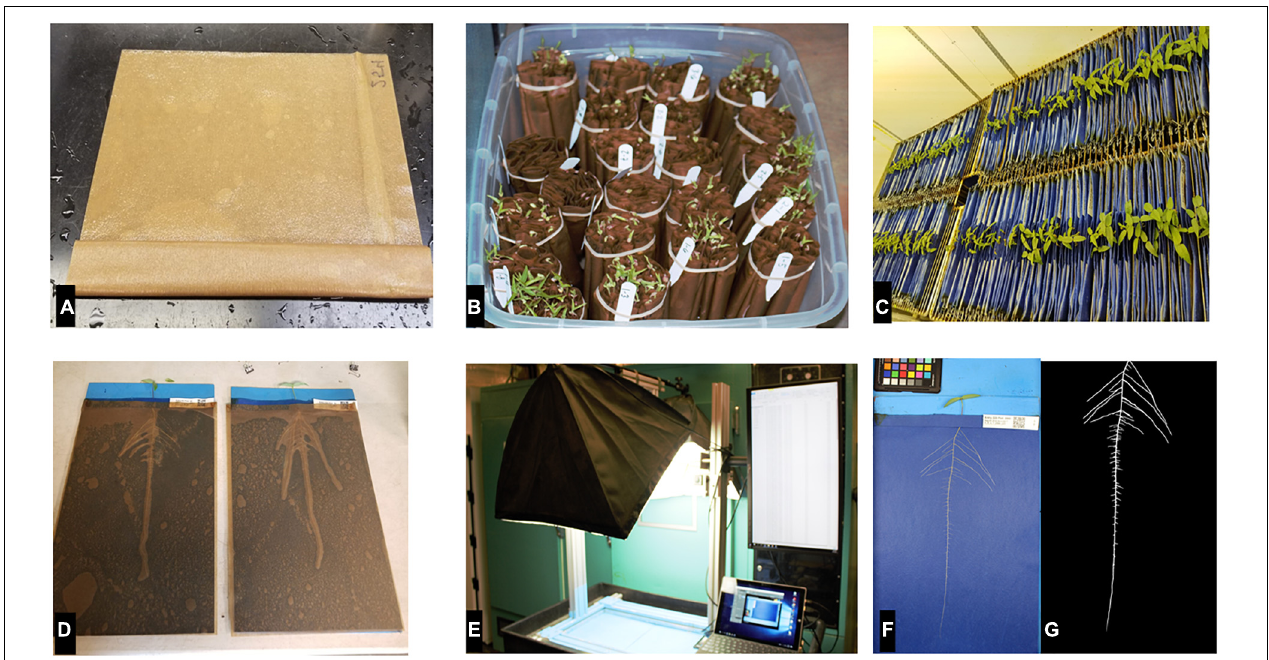
FIGURE 1 | Workflow from seed to phenotyping roots, (A) germination roll, (B) germination rolls banded by sub-block, (C) seedlings in the four blocks inside the growth chamber, (D) genotypes pooled out for imaging, (E) imaging platform, (F) captured root, and (G) preprocessed root ready for trait